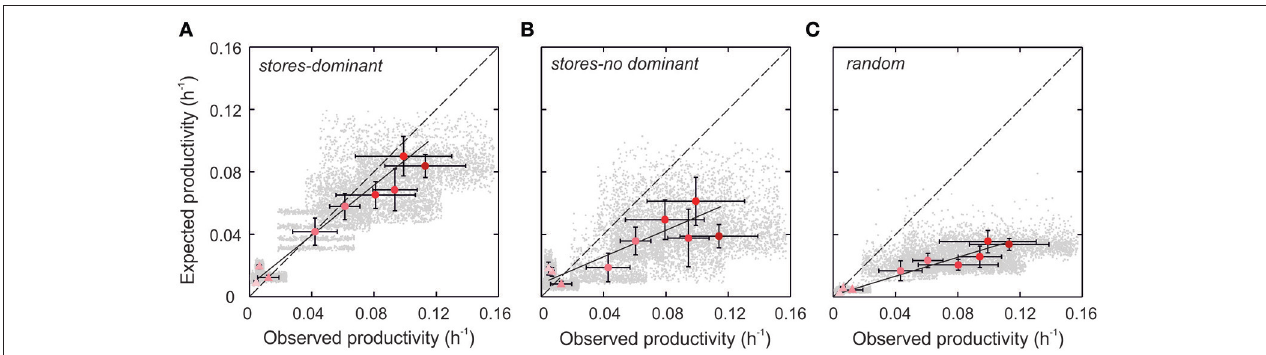
FIGURE 3 | Relationship between observed productivity and expected productivity based on internal nitrates stores assigned (A) to dominant species, (B) to non-dominant species, and (C) randomly. Monte Carlo simulations consider thousands of possible combinations of allometric parameters, including their statistical variances, relating physiological trait values to species’ cell size (gray dots). The mean values for each sampling day are also plotted (red dots). Color intensity is proportional to the magnitude of resource supply. Triangles and circles denote samples collected during winter mixing and summer upwelling, respectively. Variability in observed productivity is the standard deviation of the measurements. The dashed line is the 1:1